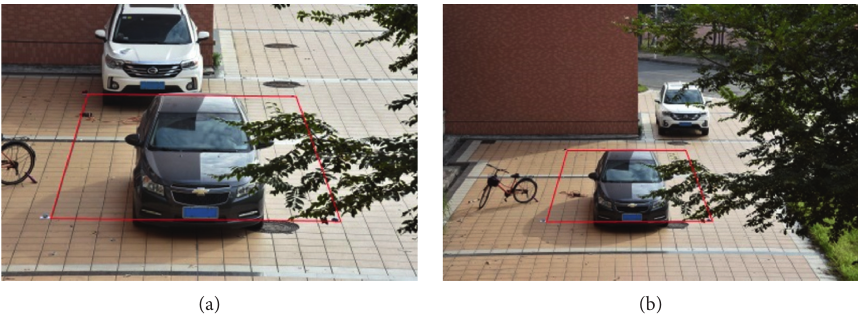
Figure 12: Calibration rectangle in the simulation experiment in our paper. (a) VIC scene. (b) RVS